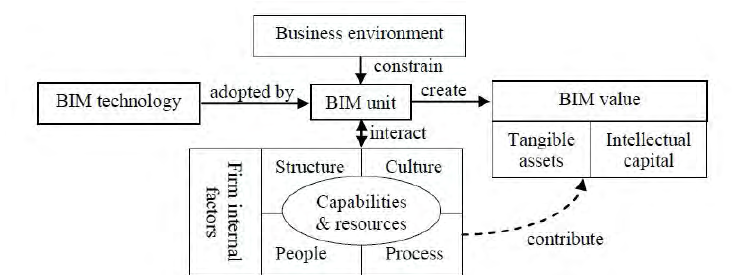
Figure 3. VisualizedBIM implementation at the corporate level, Measuring BIM performance: